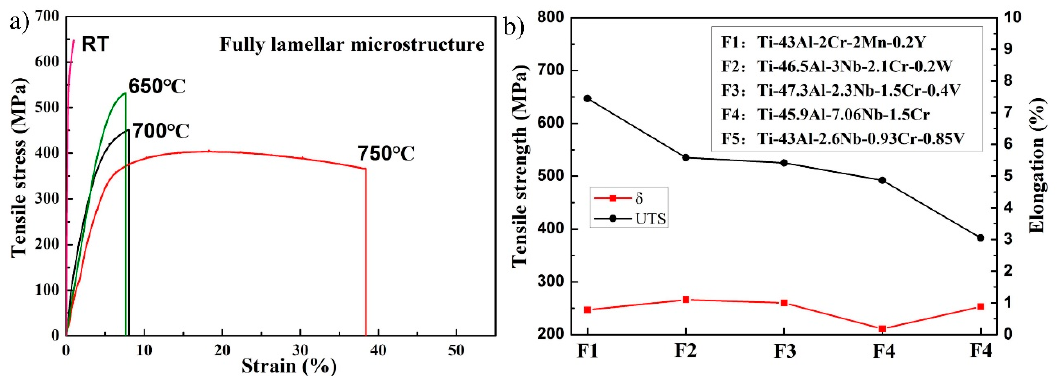
Figure 5. Tensile properties of as-forged TiAl alloys with FL microstructure: ( a ) tensile curves of the Ti–43Al–2Cr–2Mn–0.2Y alloy with FL microstructure, and ( b ) the comparison of tensile properties of various TiAl alloys with FL microstructure [24–27].